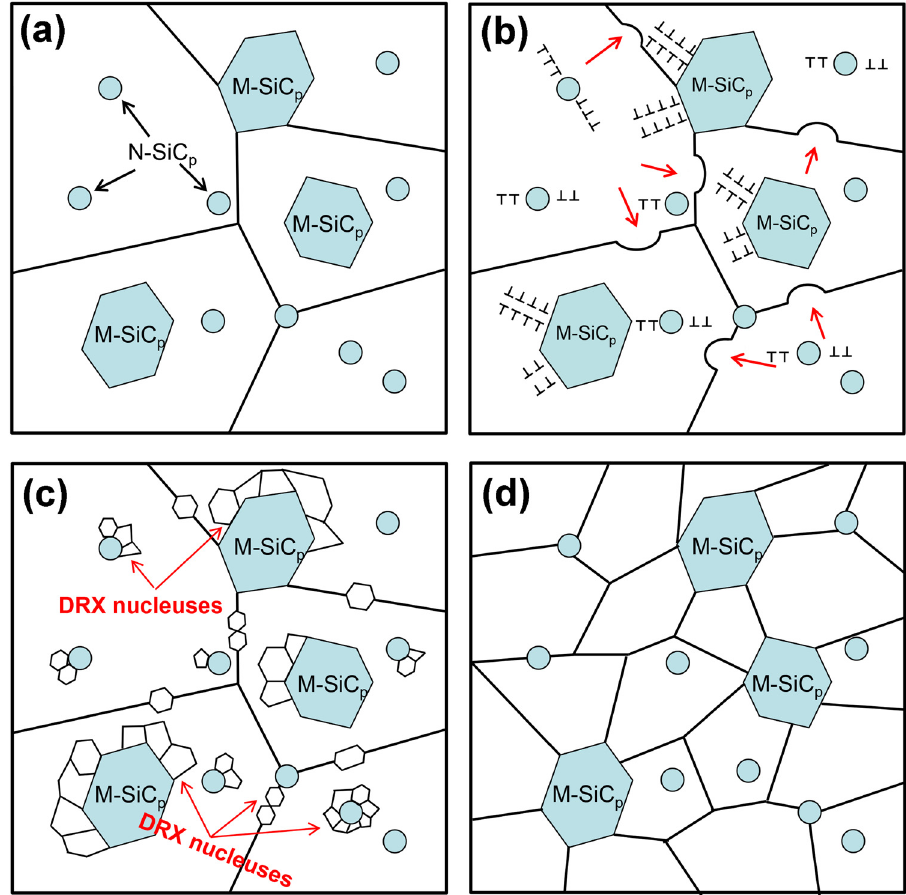
Figure 17: Schematic illustration of microstructure evolution mechanism of the used composites during hot deformation: ( a ) initial microstructure; ( b ) dislocations pile - up around reinforced particles and grain boundary bulging; ( c ) DRX nucleuses around grain boundaries and reinforcing particles; and ( d ) microstructure after